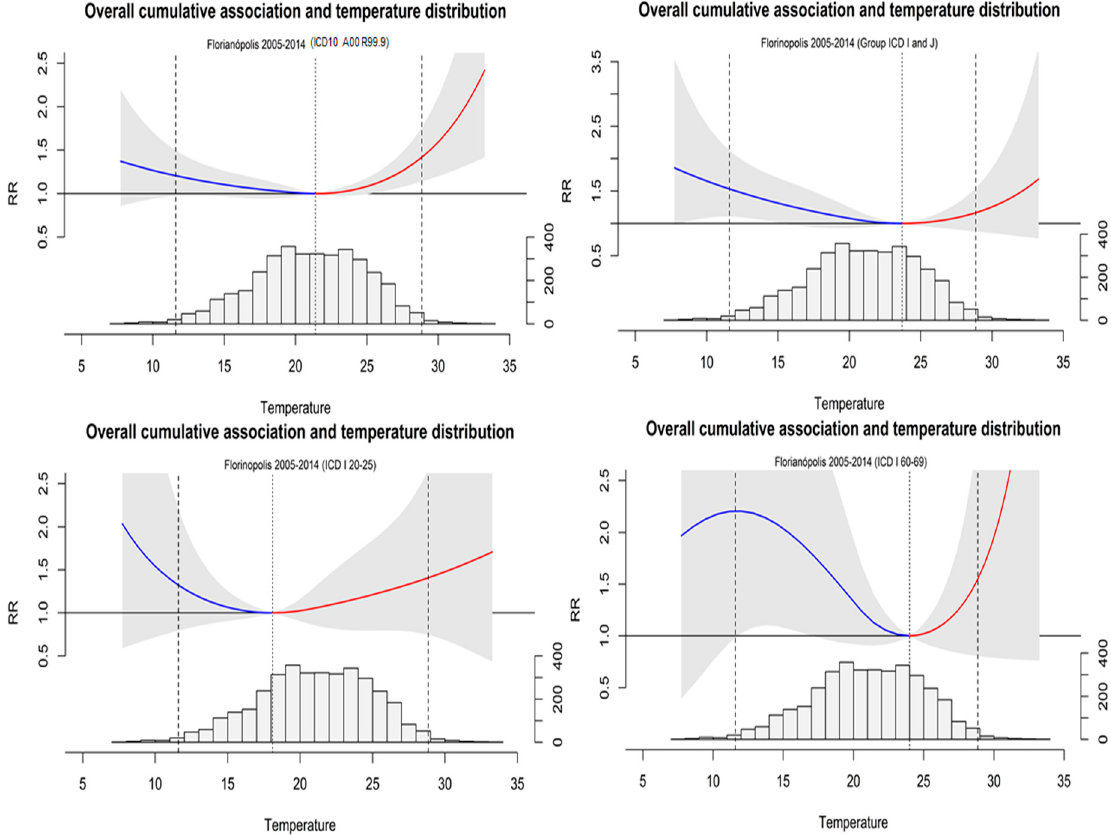
Figure 3. Grouped results for exposure-response curves for daily deaths by non-accidental mortality (ICD-10: A00-R99), groups ICD-10 diseases of the circulatory system and respiratory system (ICD-10: Groups I and J), diseases of cerebrovascular (I60-69), diseases of cardiovascular (I20-25), and histograms with the air temperature distribution for the health region of Florianopolis between the years 2005 to 2014. The red line represents values below the MMT and the blue line represents values above the MMT.